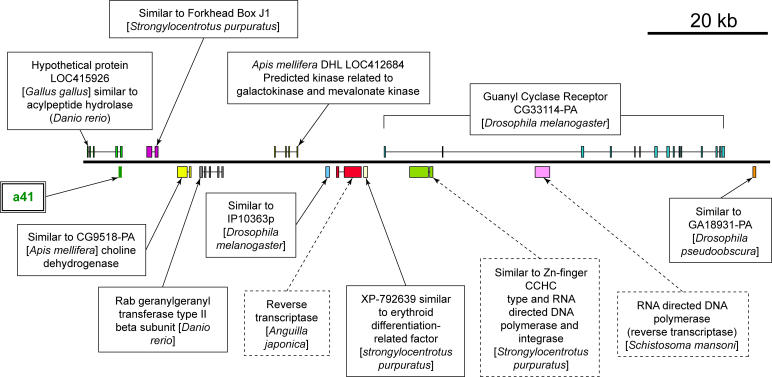
Annotation of Clone AEHM-41C10 from the Heliconius melpomene BAC LibraryThe region is situated on LG15 in the H. melpomene genome [22]. The sequence contains open reading frames of strong homology to 12 reported genes, three of which appear to be retrotransposon-associated coding regions (dotted boxes). Also highlighted in double frames are the a41 marker, which was used in H. numata and H. melpomene crosses and to isolate the clone from the library, and the Rabgeranylgeranyl transferase gene, used as a marker in H. erato crosses.